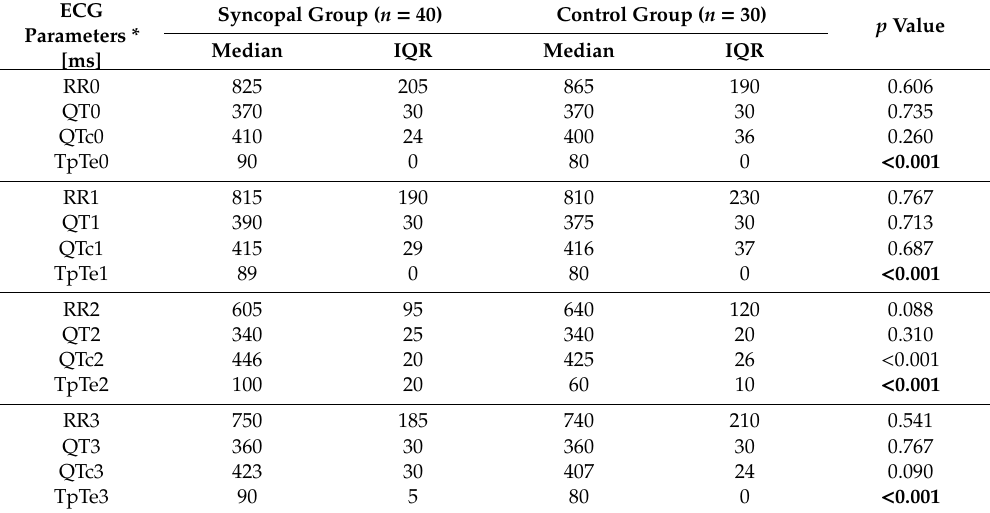
* Values of intervals in ECG during the tilt table test (HUTT) on admission to hospital (RR0, QT0, QTc0, TpTe0) and during the rest phase (RR1, QT1, QTc1, TpTe1), the upright 2 phases (RR2, QT2, QTc2, TpTe2), and recovery phase (RR3, QT3, QTc3, TpTe3). Values [ms] are shown as a median and interquartile range (IQR). QTc intervals corrected for the heart rate (HR) using the Bazett’s formula. A significant di ff erence ( p < 0.05) (shown in bold) while comparing Syncopal group to the Control group was calculated using the Mann-Whitney U test with the Marascuillo and McSweeney continuity correction.